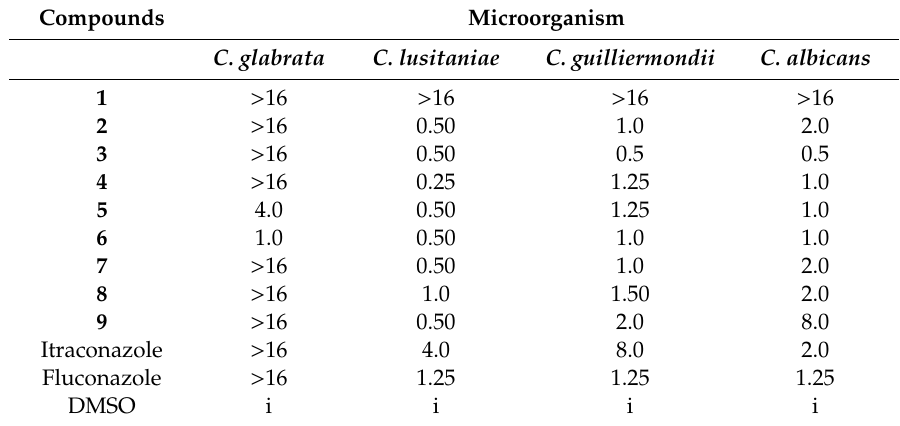
Table 2. Antifungal activities determined in a liquid medium and expressed by a MIC 80 in µ g / mL at 48